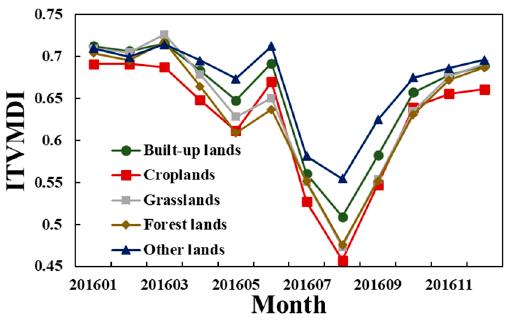
Figure 8. Monthly change in the average iTVMDI of different land covers in the whole year.